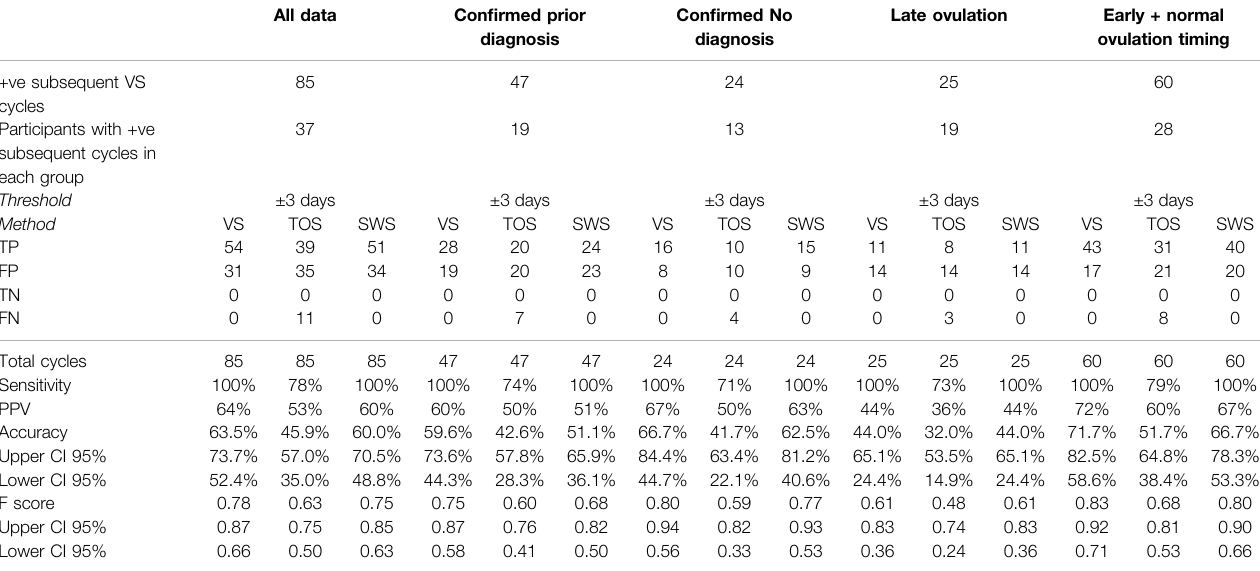
TABLE 13 | Threshold method results for VS, TOS, and SWS ovulation prediction compared with VS subsequent cycle results using median day of ovulation prediction method for all data, and diagnosis and ovulation timing groups. All